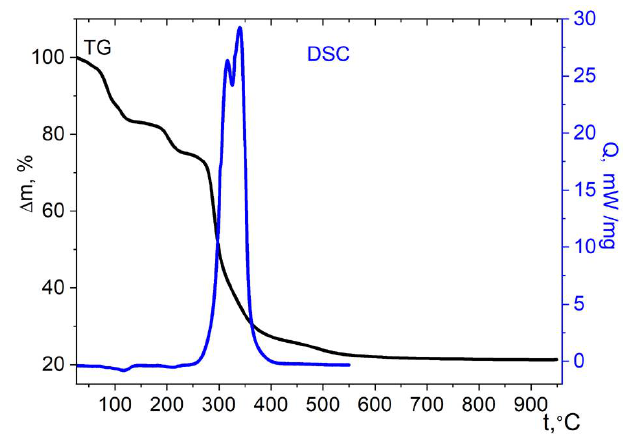
Figure 13. Thermolysis of complex 5 under air. The mass loss during the thermolysis of complex 6 , according to TG data, begins at 25 °C already, and the mass loss corresponding to the elimination of water and toluene lattice molecules (8.5%) is achieved at 50 °C (Figure 14). The further intense weight loss is possibly associated with the removal of a water molecule and one of the bpy ligands from the inner sphere, with the introduction of the outer cymantrenecarboxylate ligand into the inner sphere of the complex. However, the corresponding weight loss (down to 73.64% of the initial) is achieved at a temperature of 215 °C, when the coordinated bpy is not firmly withheld and its further removal is possible, as it was found for nickel chloride [57] and